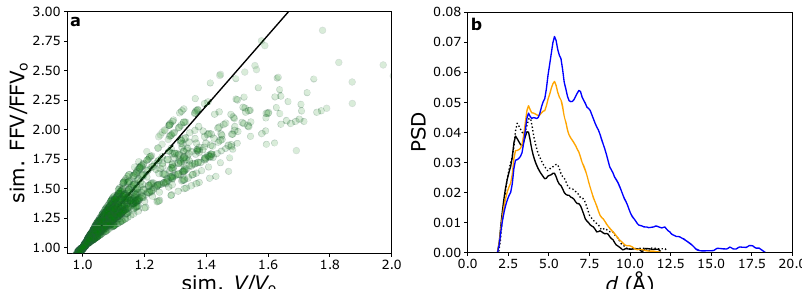
Fig. 5 Assessment of adsorption-induced fractional free volume (FFV) restructuring. a Comparison of fractional free volume (FFV) dilation and volumetric swelling for the full set of adsorption conditions we considered. The diagonal black line has a slope of 3.0 and denotes the initial swelling ( V/V o < 1.15) relationship. b Example pore size distributions (PSD) normalized by FFV for PIM-1n2 and acetone: solid black (static framework), dotted black (theoretical 11% proportional swelling), orange (11% simulated swelling), blue (33% simulated